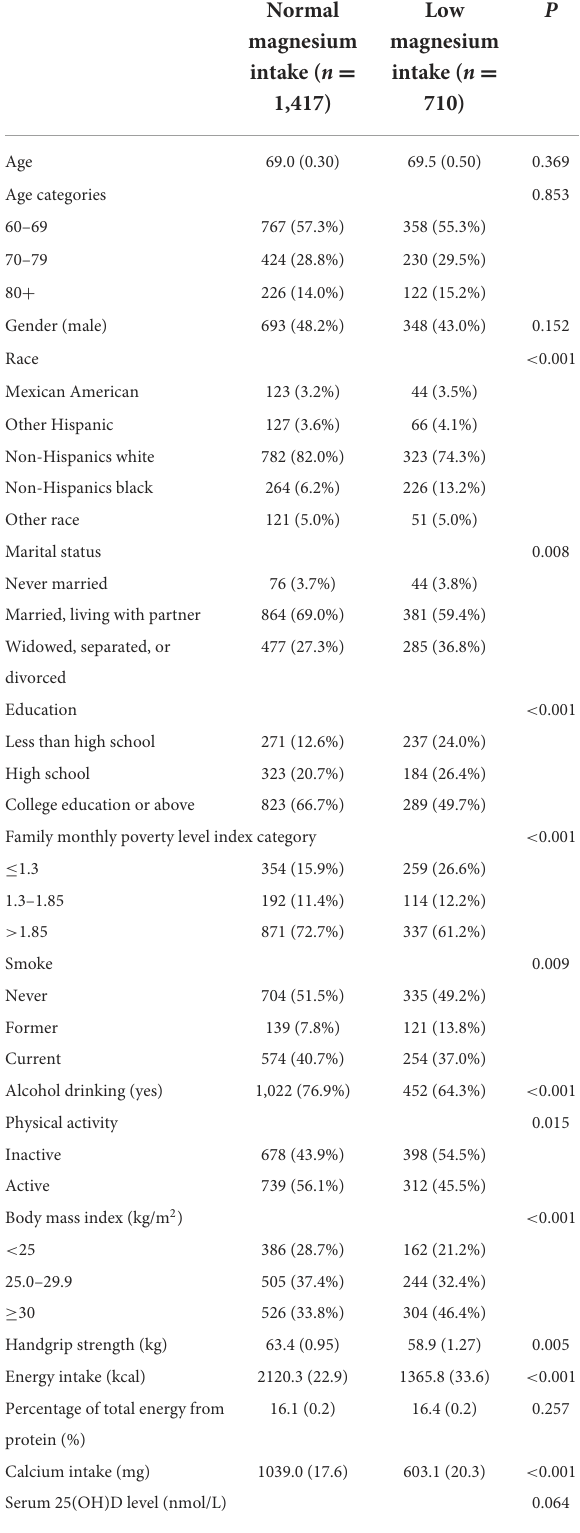
TABLE 1 Baseline characteristic of participants with and without low magnesium